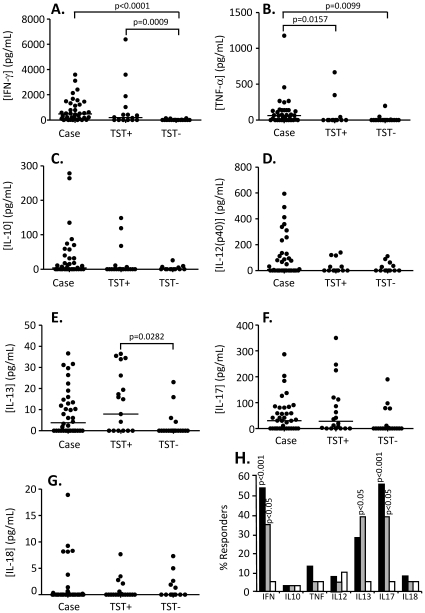
Cytokine responses following EC stimulation.Whole blood from TB cases (n = 36), TST+ (n = 20) and TST− (n = 19) contacts was stimulated for 7 days with ESAT-6/CFP-10 fusion protein and the supernatant assessed by multiplex cytokine analysis. A) IFN-γ. B) TNF-α, C) IL-10, D) IL-12(p40), E) IL-13, F) IL-17 and G) IL-18. Line indicates median. Data were analysed using Tweedie distributions with p-values indicating significant differences after adjustment for age and sex. H) Percentage of responders (prior to adjustment for age and sex) producing IFN-γ, IL-10, TNF-α, IL-12, IL-13, IL-17, IL-18. Dark bars = cases, grey bars = TST+ contacts, white bars = TST− contacts; p-values are indicated and refer to comparison with TST− contacts.